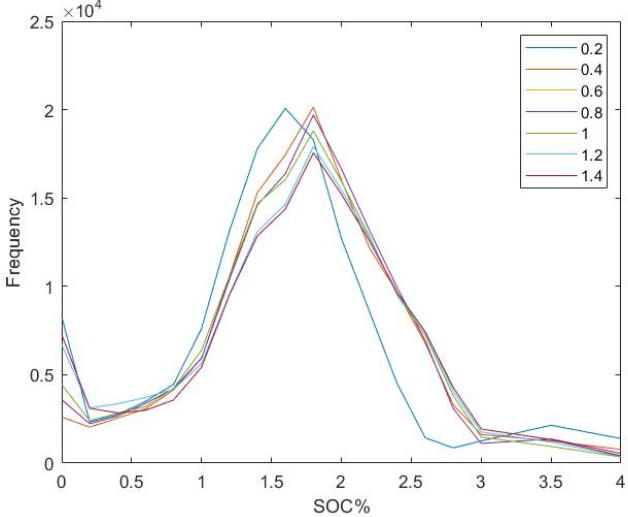
Figure 8. Histogram of the estimated SOC content from both the sites with varying AOD.